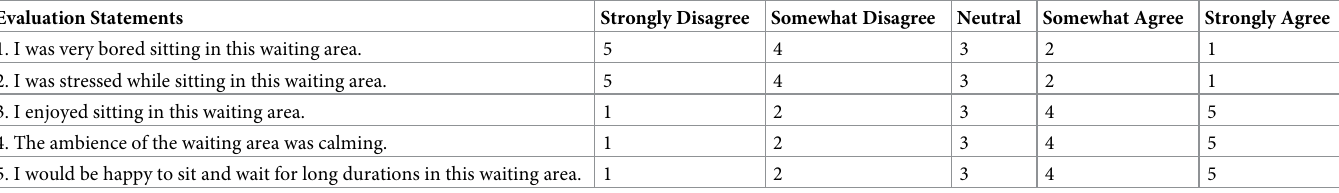
Table 1. Questionnaire for subjectively assessing the waiting area experience of the